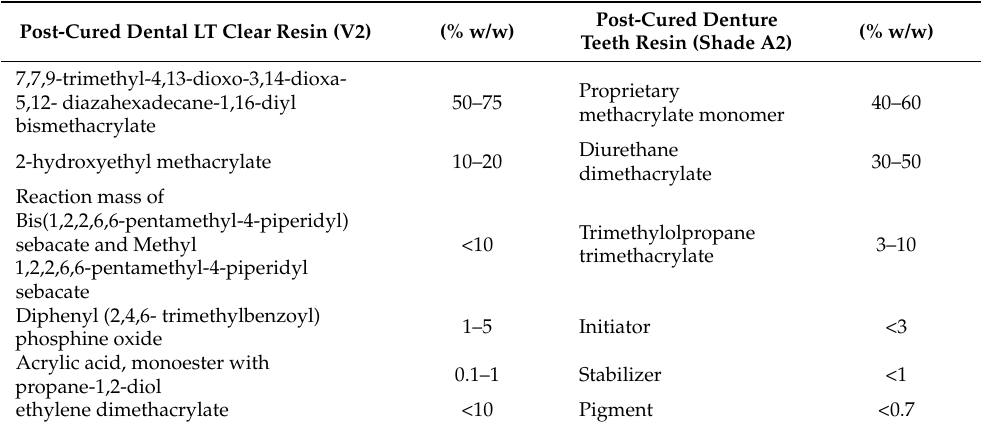
Table 3. Chemical composition of Dental LT clear and Denture teeth Resin (Formlabs,